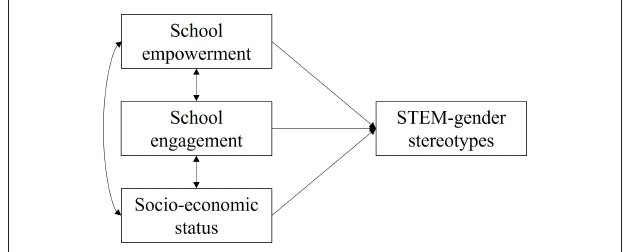
FIGURE 1 | The theoretical model to be estimated across gender and national context (Italian males, Italian females, Nigerian males, and Nigerian